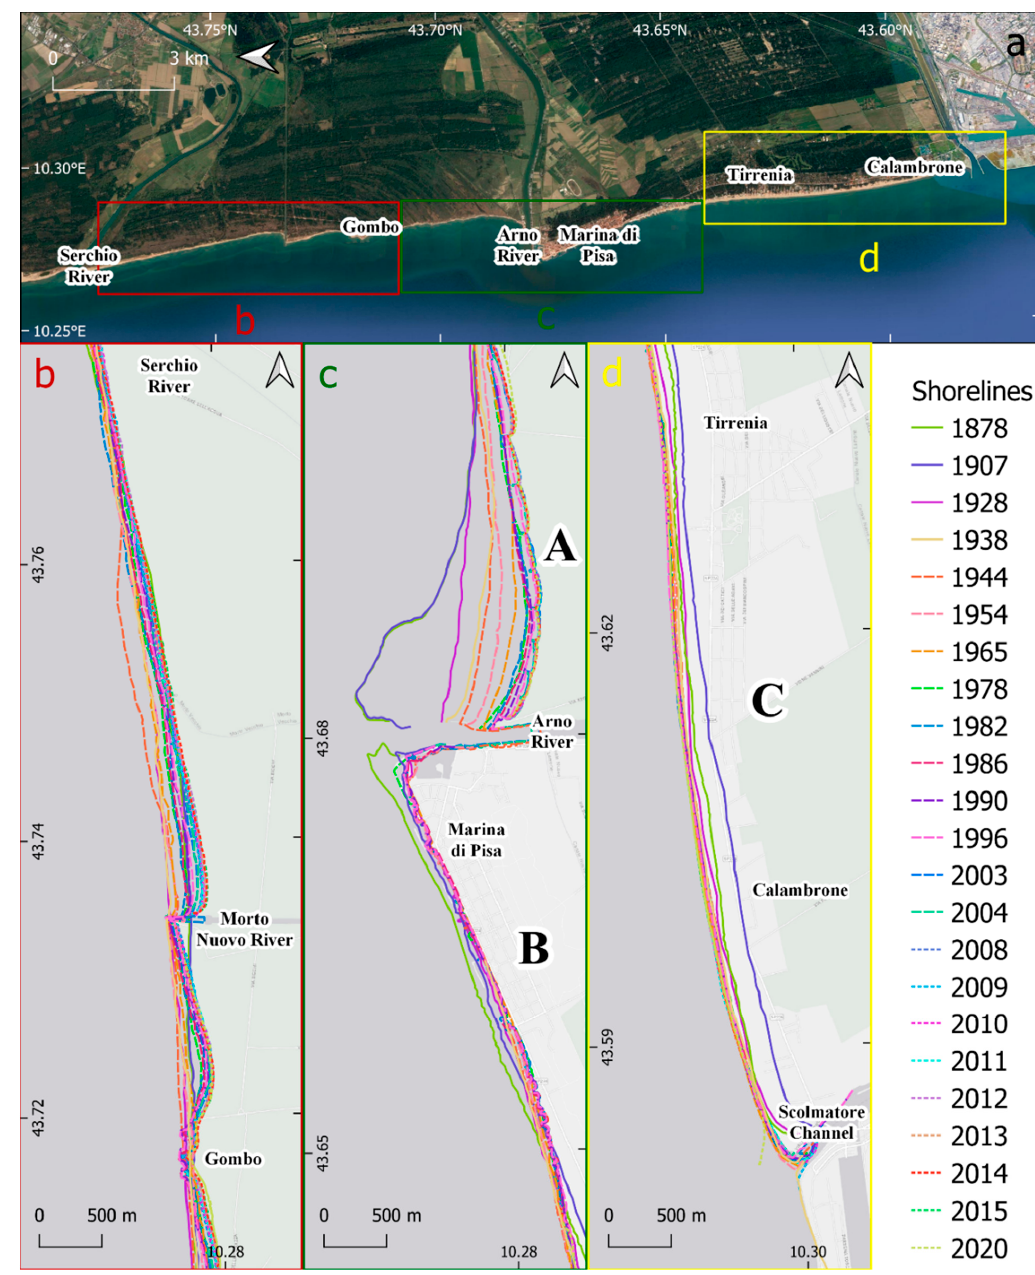
Figure 2. Location of the analyzed coastal sectors ( a – d ). Shorelines extracted from the various sources reported in Table 1. A, B and C indicate specific coastal stretches to which reference has been made in the text. Continuous lines: data from historical maps or aerial photography; dashed lines: data from Differential Global Position System (DGPS) measurements.